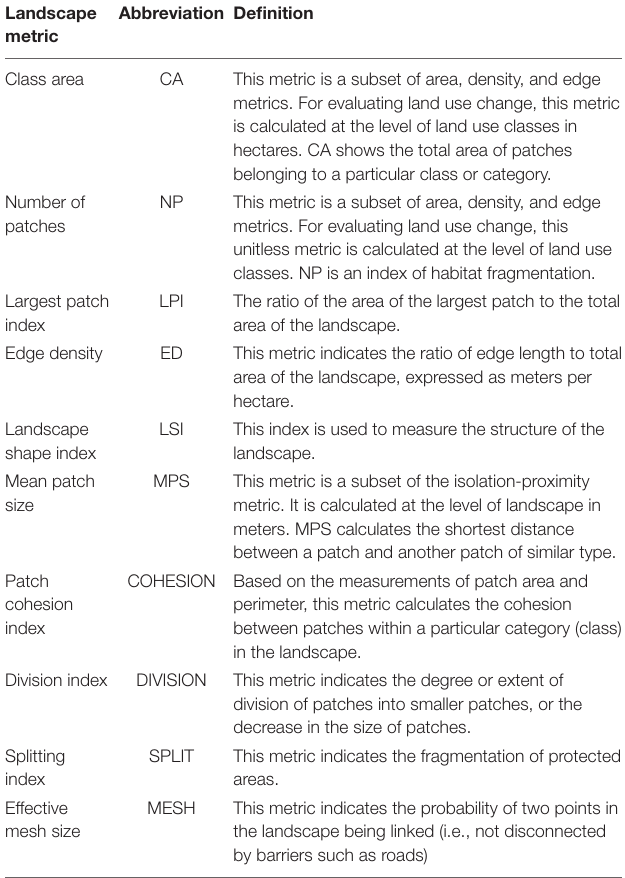
TABLE 1 | Metrics used for the analysis of fragmentation and degradation of protected areas, rangeland, and forest land